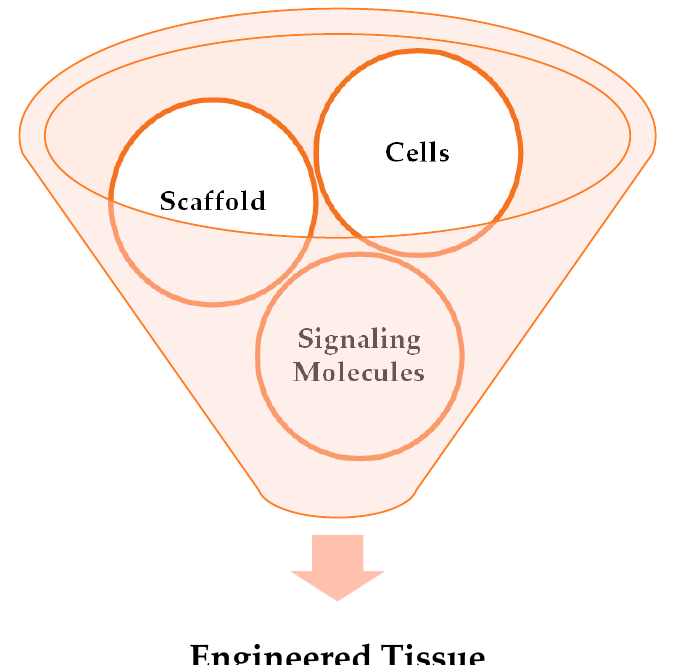
Figure 1. Vital elements of tissue engineering (simplified diagrammatic representation of the basic concept of tissue engineering, i.e., scaffold, cells, and growth-stimulating factors are the three essential parameters responsible in tissue engineering for forming new functional tissue).